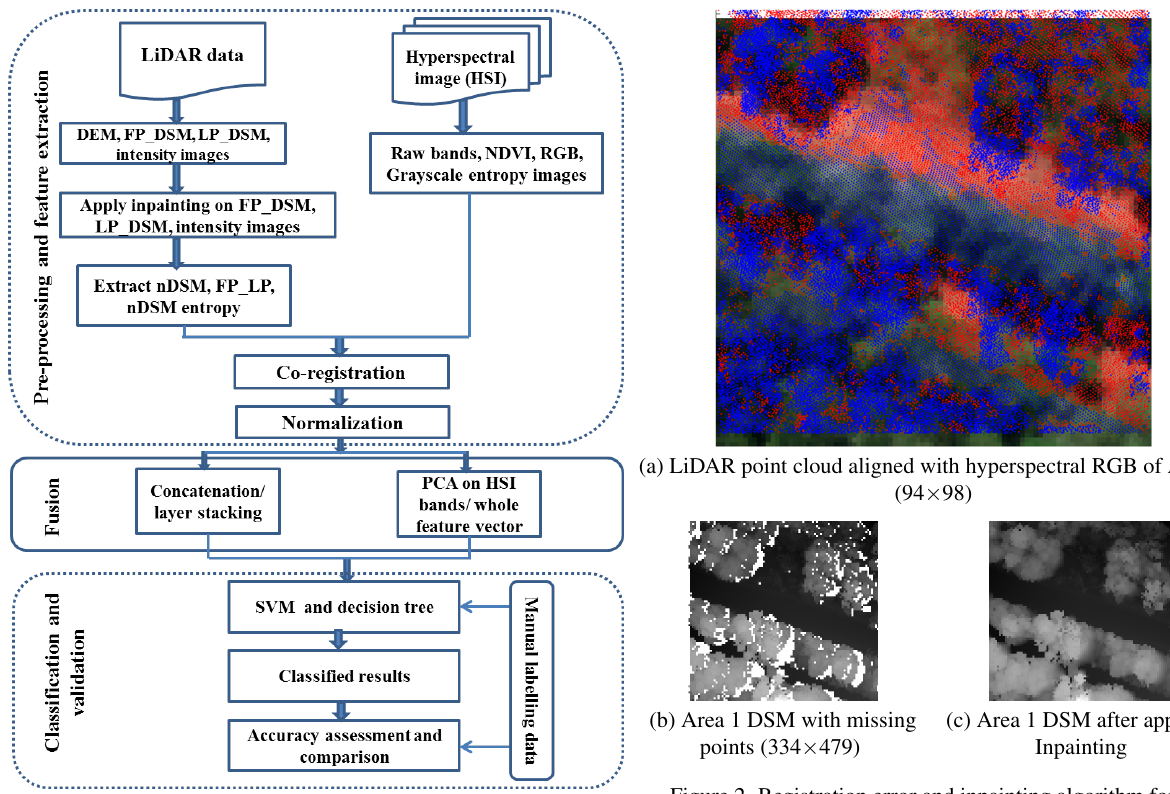
Figure 1. Proposed Framework.